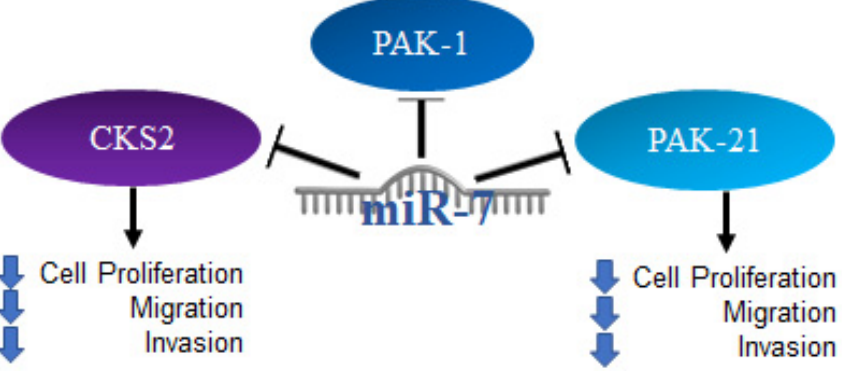
Figure 8. Role of miR-7 in thyroid cancer. Schematic representation of protein interactions with miR- 7 and its biological consequences in thyroid